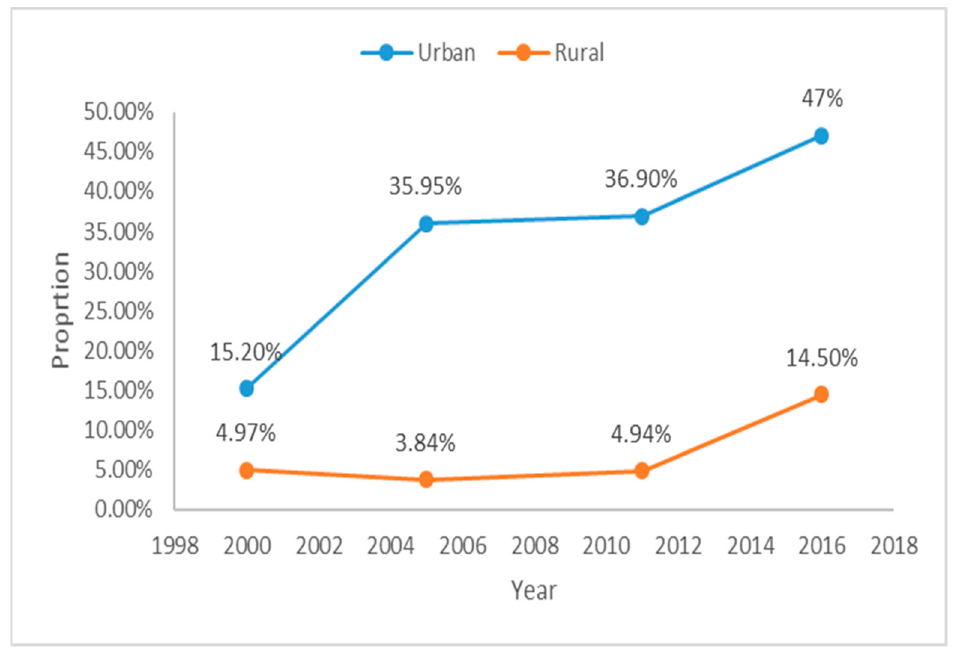
Figure 3. Trends of PNC in urban and rural women of Ethiopia (EDHS) 2000–2016.